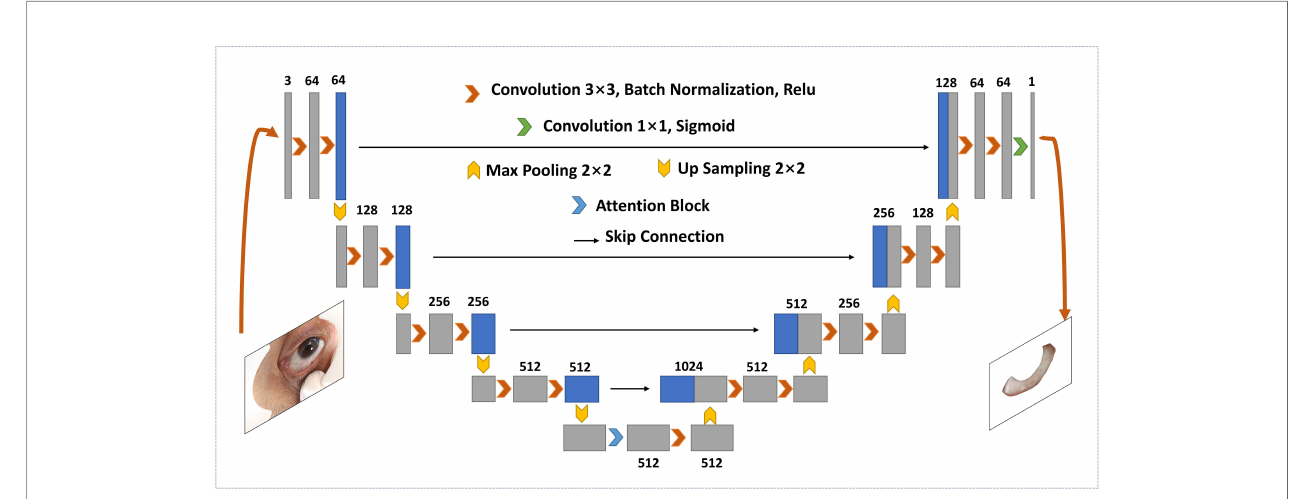
FIGURE 2 | Overview of the scleral segmentation model embedded with attention